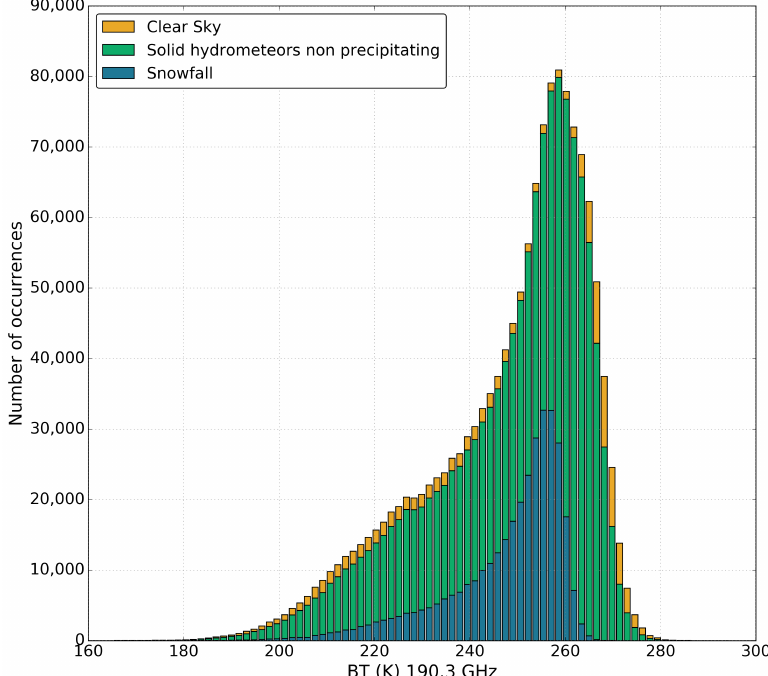
Figure 3. Number of occurrences as a function of the BT (K) at 190.3 GHz for the different types of detected